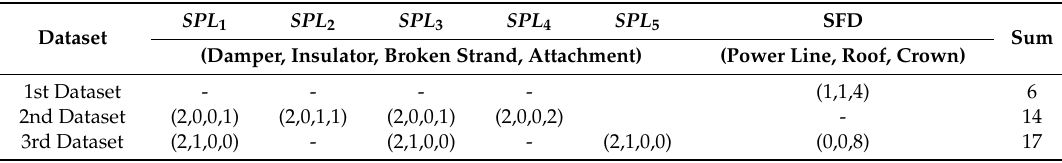
Table 3. Object distributions of the three